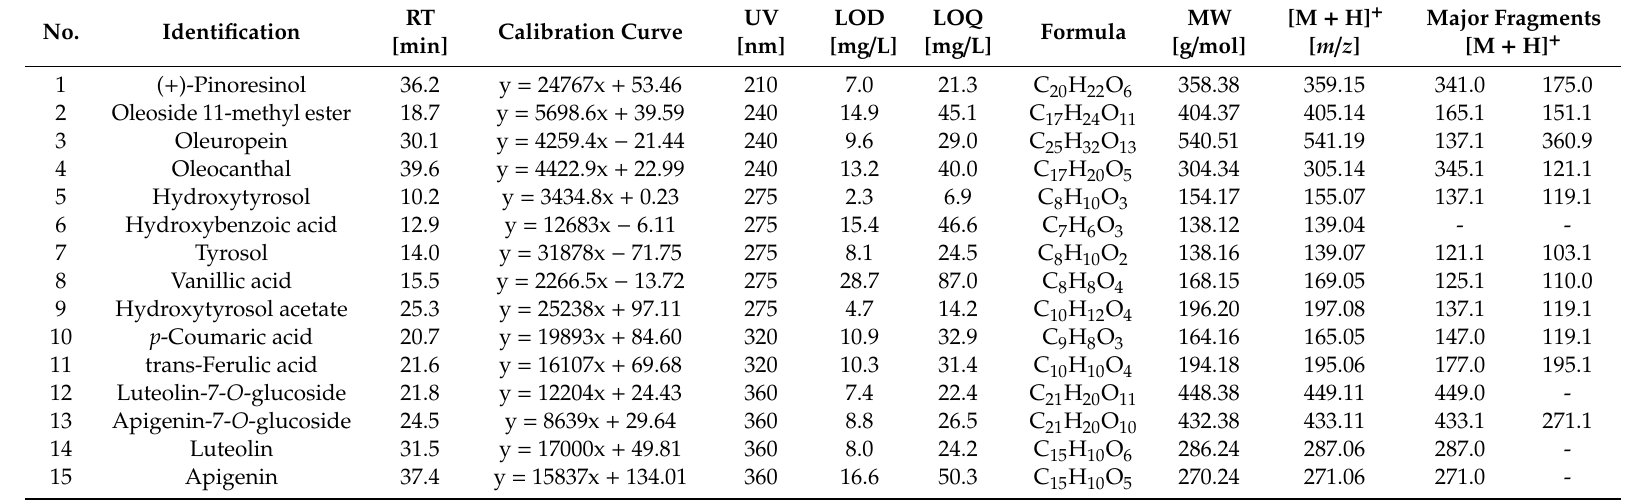
Table 2. Mass spectrometric identification